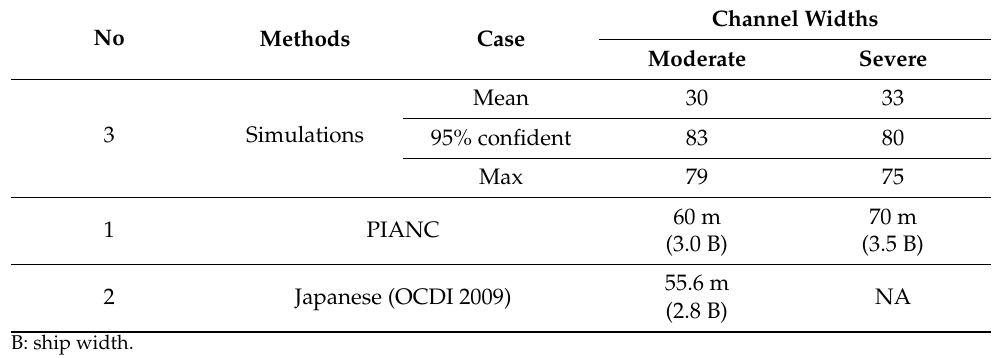
Table 2. Channel widths were obtained from different methods for two wind speeds.